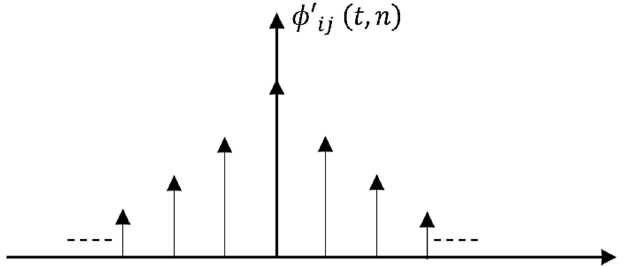
Figure 10. The autocorrelation of the colored signal x (cid:48) ( n ) .